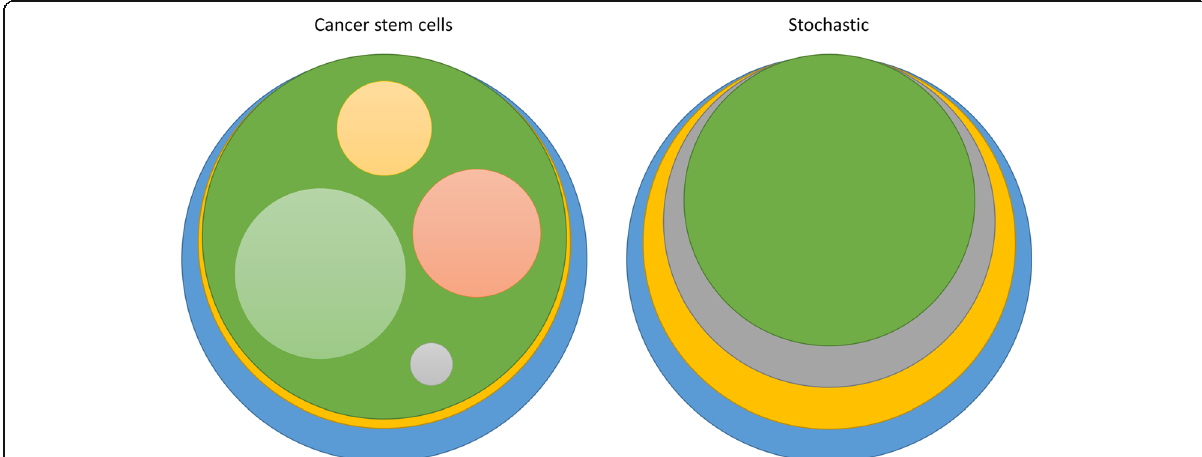
Fig. 4 Different models of tumour development and the consequential tumour composition. Each circle represents a pool of cells with identical genetic alterations. In a cancer stem cell model, a vast pool of mutated stem cells produces daughter cells carrying its progenitor ’ s mutations and mutations unique for that clone. Characteristic for this model is the presence of multiple coexisting clones in the tumour mass. In a stochastic model, cells follow a specific path of mutations leading to increasingly smaller fractions which carry all its progenitor ’ s mutations. Sub-clones carrying different sets of mutations are unlikely in this model and thereby this model best reflects what we observe in